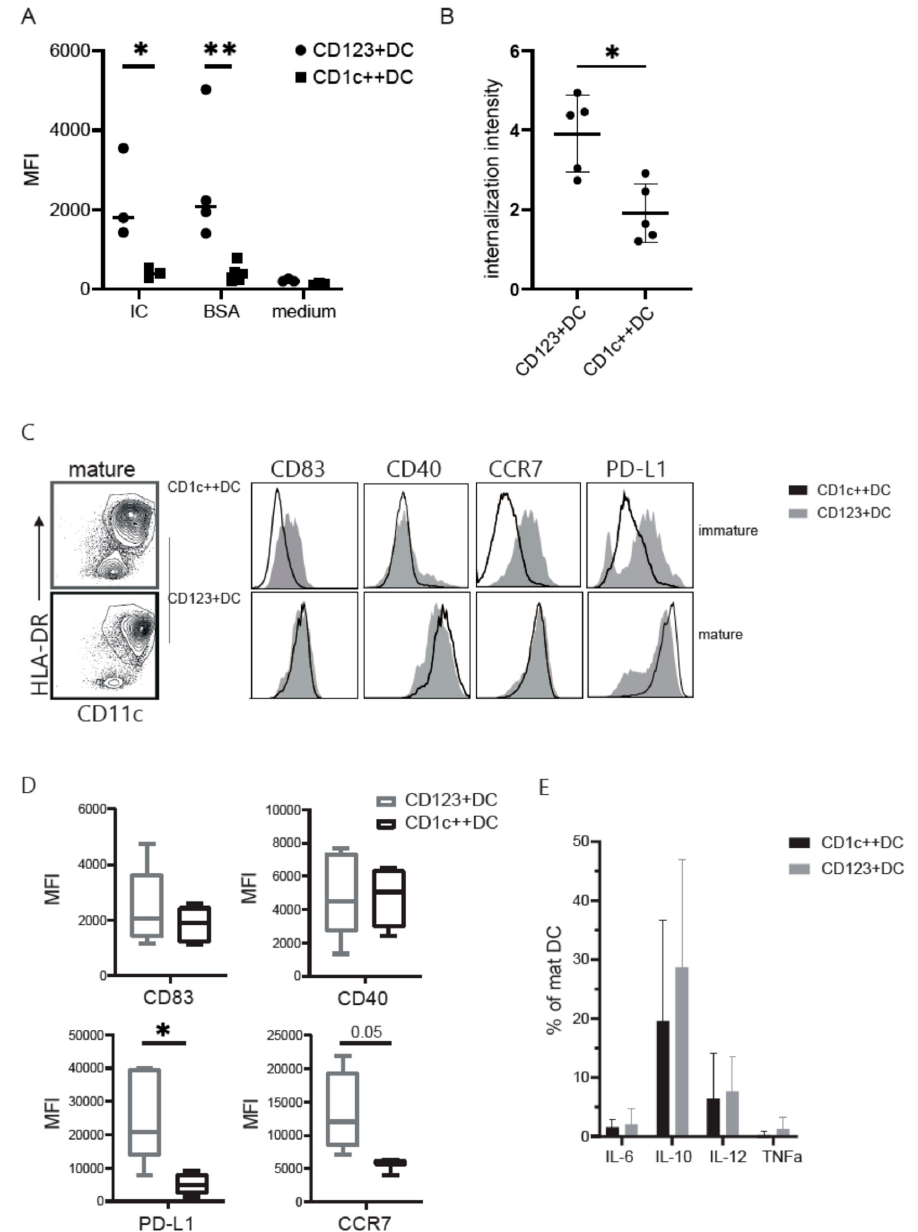
Figure 3. Uptake by different DC subsets and DC maturation. ( A ) Uptake of 5 ug/mL BSA-FITC or 5 ug/mL BSA immune complex (IC) by CD1c++DC and CD123+DC compared to the medium. The geometric mean of FITC + signal within the DC subsets taken up at 37 °C is shown. Sidak multiple comparisons were used to test significance * = p < 0.05, ** = p < 0.01. ( B ) The internalization intensity calculated within the DC subsets after uptake of BSA-FITC. Internalization was based on the Imagestream X internalization feature, defined as the ratio of intensity measured inside a cell to the intensity of the entire cell analyzed using the IDEAS software. Data represent two independent experiments. The Mann-Whitney analysis was used to test significance * p < 0.05. ( C ) For the FACS analysis, live cells were gated with SSC/FSC, followed by doublet exclusion based on FSC-H/FSC-A. Gating of DC (HLA-DR+CD11c+), and thereafter CD83 and PD-L1 before and after maturation with cytomix. ( D ) Mean fluorescent intensity of CD83, CD40, PD-L1, and CCR7 on matured DC (live/single/CD11c+HLA-DR+) of the DC subsets. Significance was assessed using the Mann-Whitney test (* = < 0.05). ( E ) Intracellular cytokines (IL-6, IL-10, IL-12 (p40/p70), and TNF-alfa stained after fixation and permeabilization within DC subsets after maturation. ( D , E ) Experiments were performed with four different